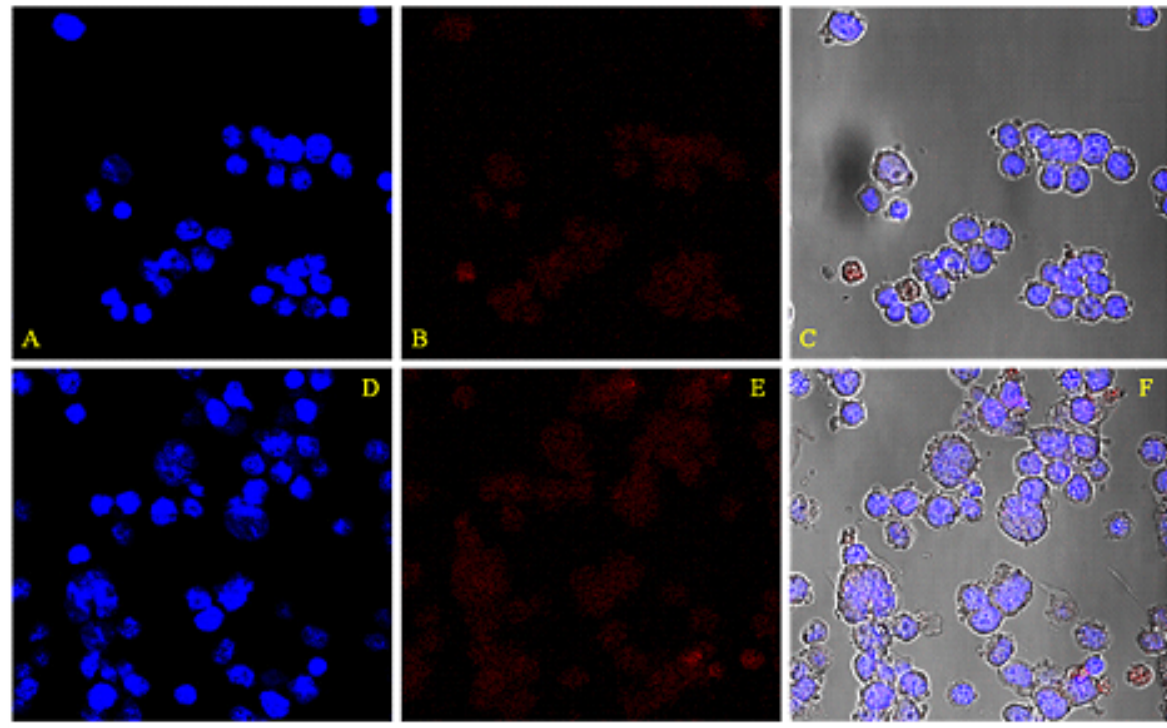
Figure 4. Intracellular localization of CMD-TMC-NPs (A–C) and CMD-TCs-NPs (D–F) in Y79 cells by Cy5-labeled NPs. Labeled NPs appear in red in the confocal microscopy fluorescence